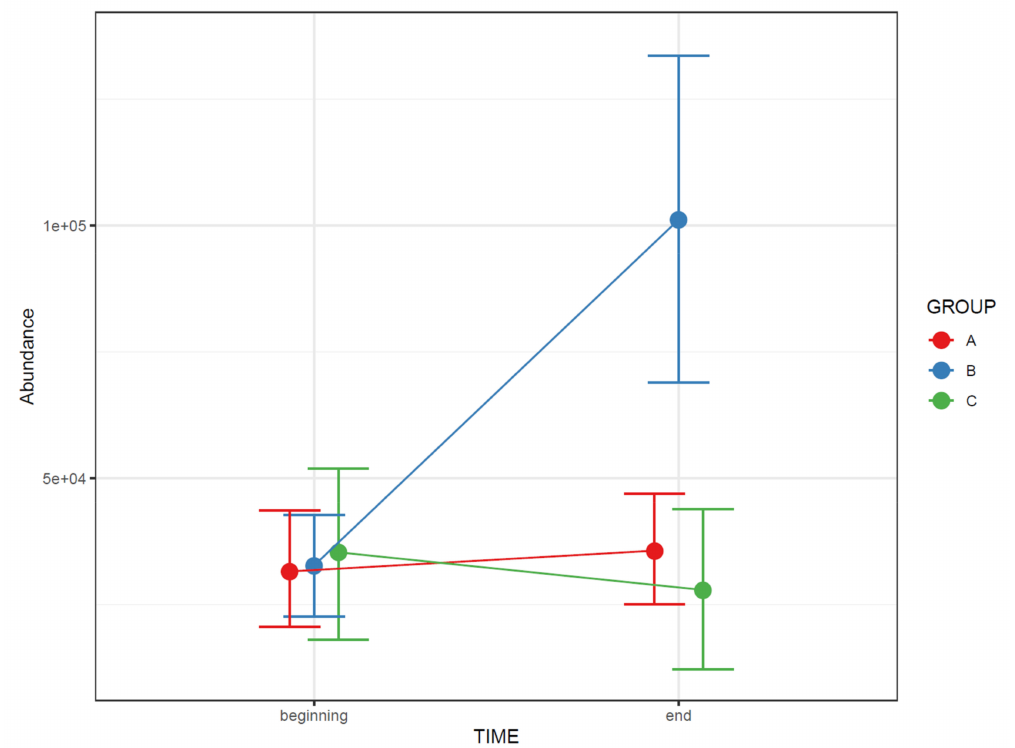
Figure 16. The change in the abundance of a molecular feature as a function of time in each study group. The whiskers depict 95% confidence